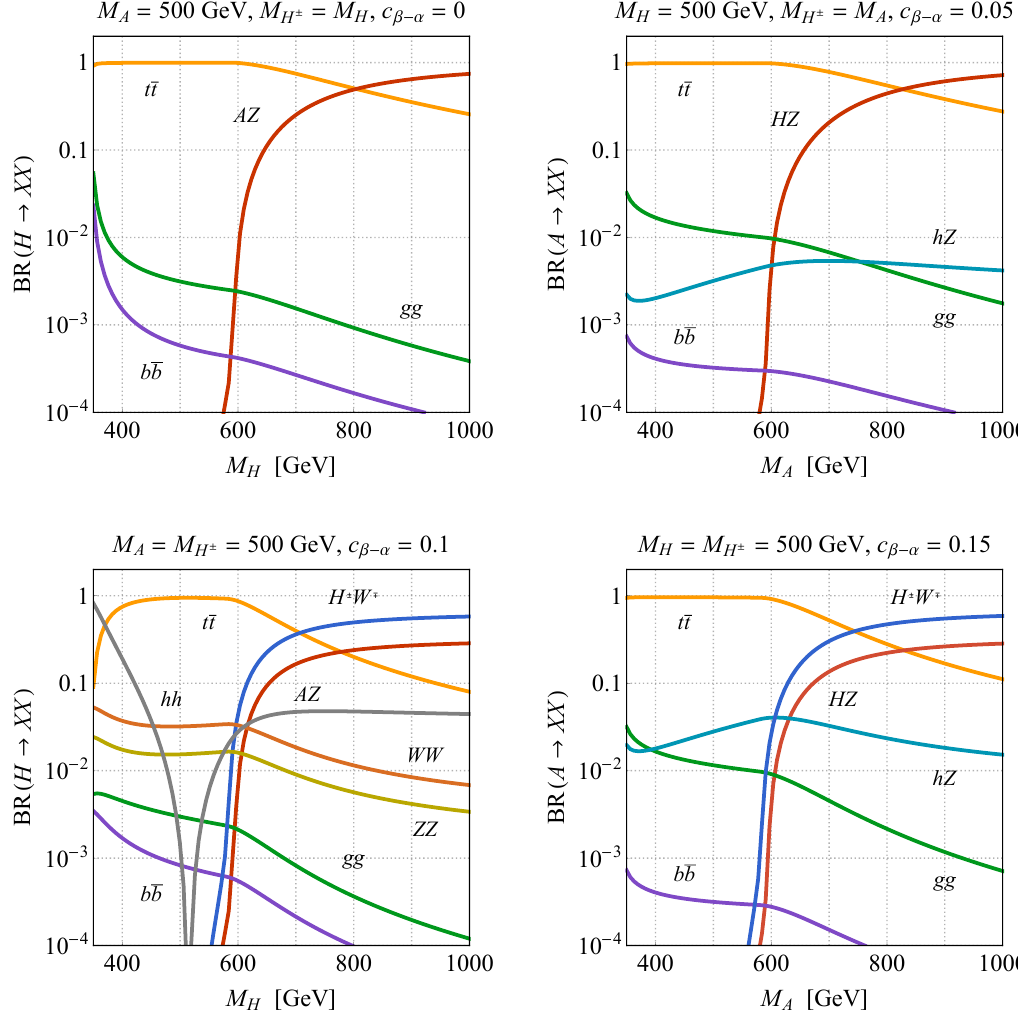
Figure 1 . Branching ratios of the heavy Higgses H and A in the type-II 2HDM. The shown results all correspond to t (cid:12) = 1, while di(cid:11)erent parameter choices have been used for M H ; M A ; M c (cid:12) (cid:0) (cid:11) as indicated in the headline of the panels.